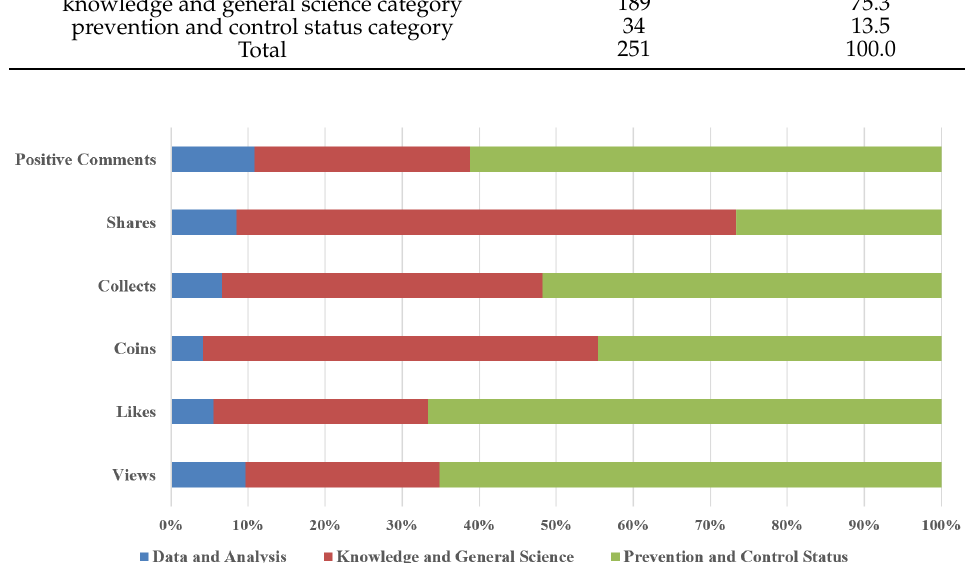
Figure 2. The popularity level of COVID-19 videos under different video content